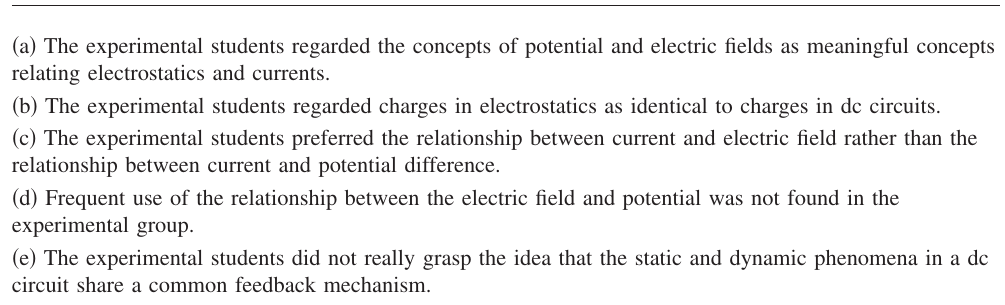
TABLE VI. Teachers’ analysis of data collected from 85 “experimental group” students and 68 “com- parison group”